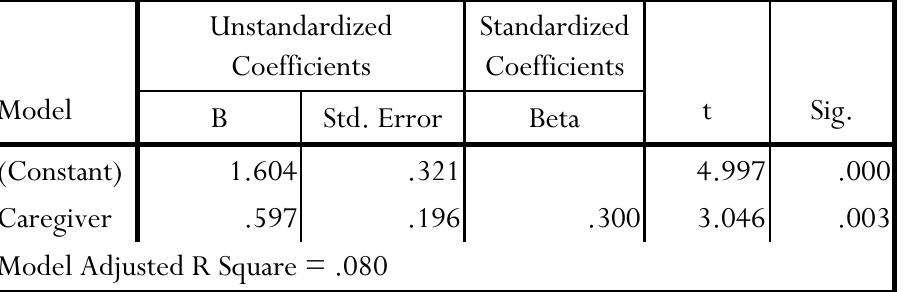
Table 16: Linear Regression of Number of Victimizations on Duration of Stealing